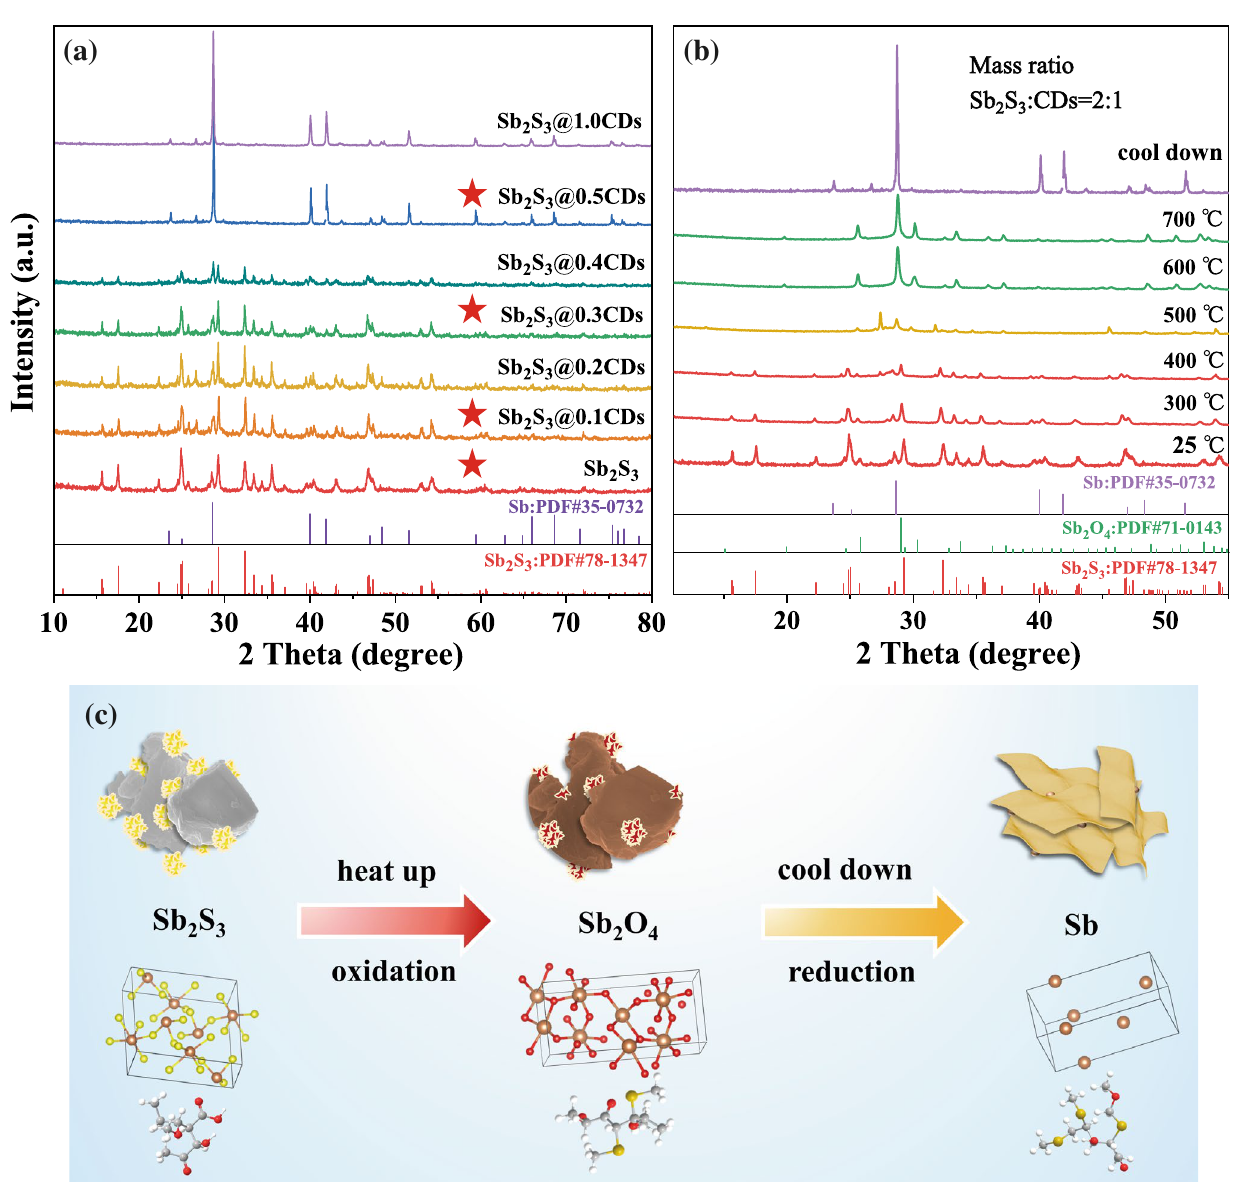
Fig. 1 Phase and structure characterization. a XRD patterns of Sb 2 S 3 @xCDs and Sb 2 S 3 . b HT-XRD for Sb 2 S 3 @0.5CDs from 25 to 700 °C under nitrogen atmosphere with a heating rate of 10 °C min −1 . c Schematic for the formation process of Sb 2 S 3